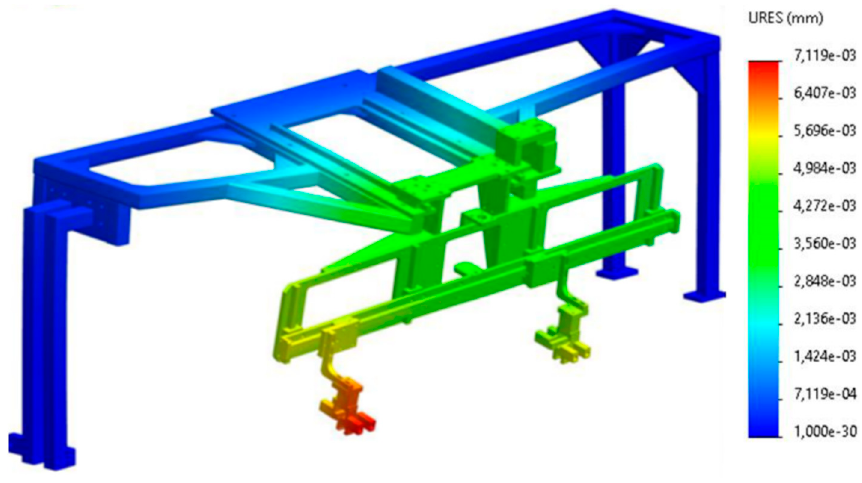
Figure 16. Magnitude of displacement in the manipulator’s structure under working loads.